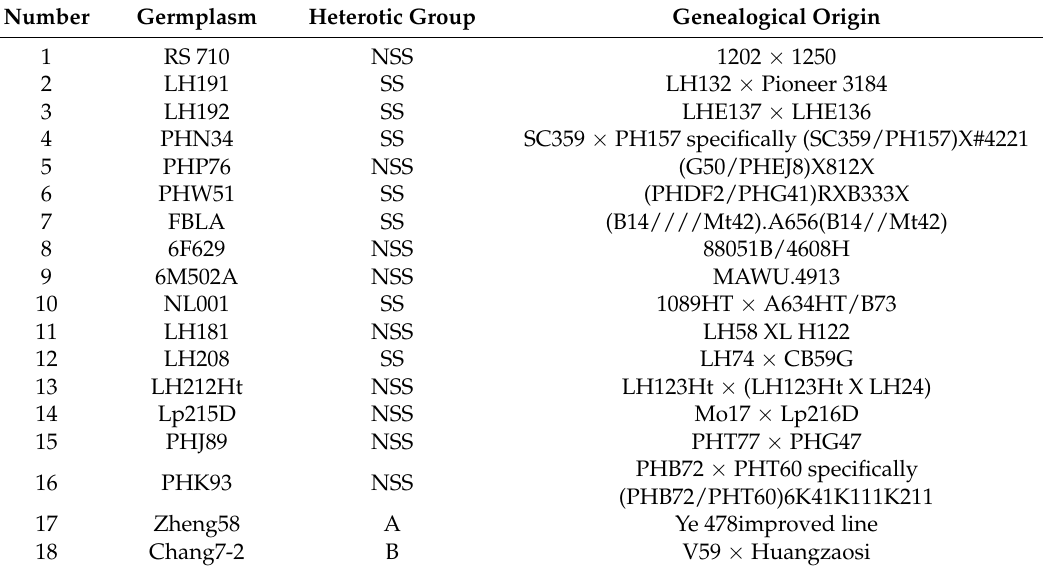
Table 1. Genealogical origin of USA maize inbred lines and China